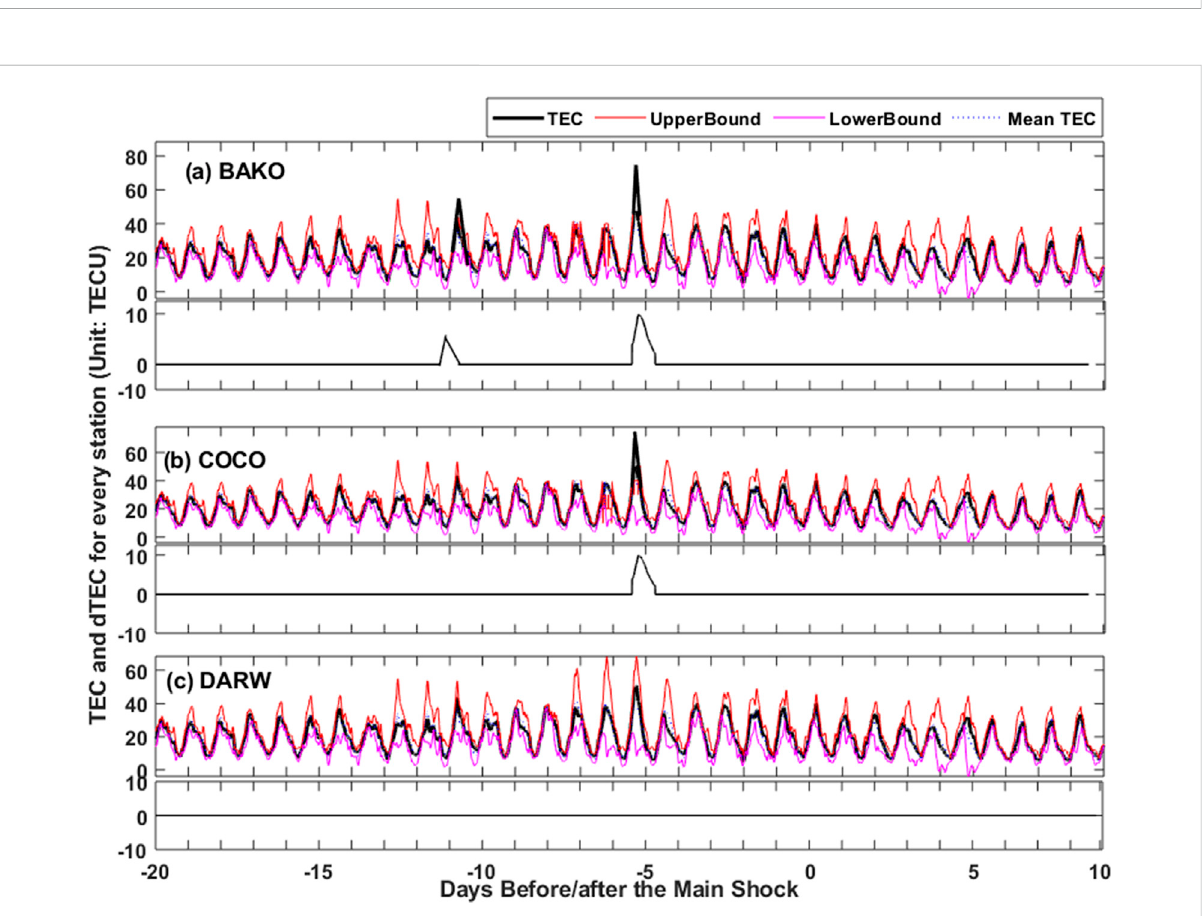
FIGURE 4 TEC from GPS stations (A) Bako, (B) Coco, and (C) Darw with their differential TECs before and after the M w 6.5 Sumatra earthquake. The bold black line represents TEC, whereas the red and pink lines represent the con fi dence bounds.